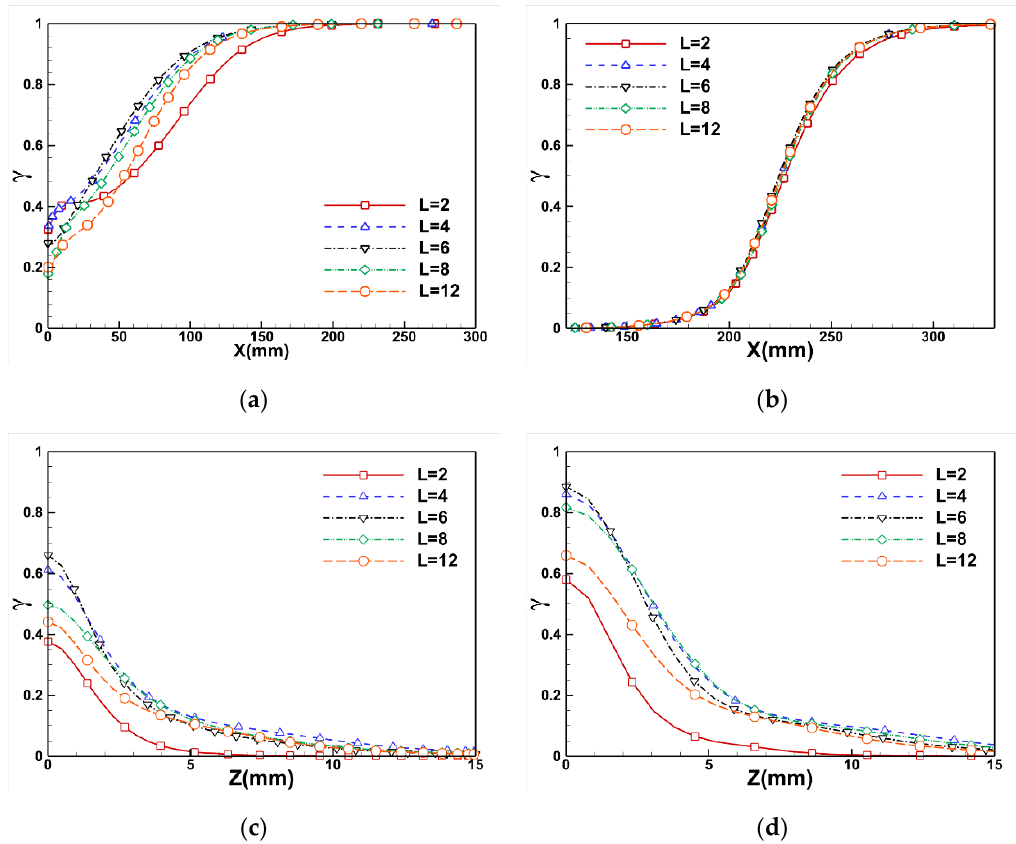
Figure 13. Distributions of γ . ( a ) L = 2 mm, ( b ) L = 6 mm, ( c ) L = 12 mm.